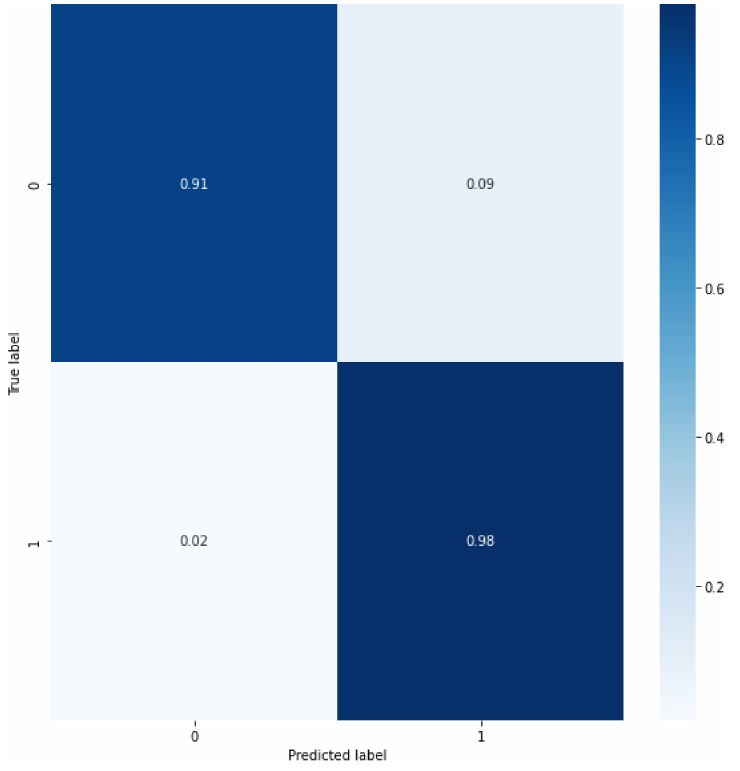
Figure 14. The result of the confusion matrix GRN. Table 6. The experiment results of the GCN model in every aspect.